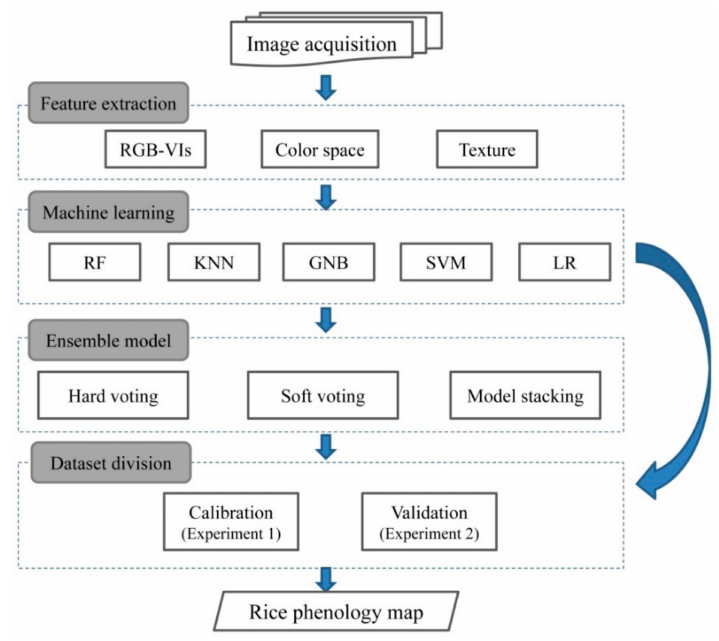
Figure 3. Schematic diagram of the proposed